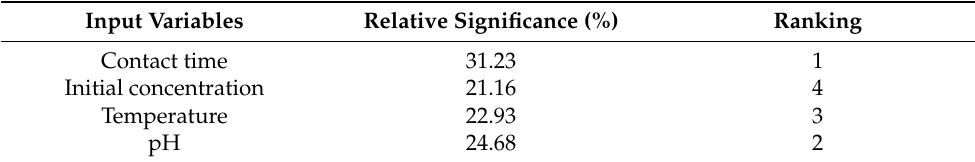
Table 11. Relative significance of input variables.